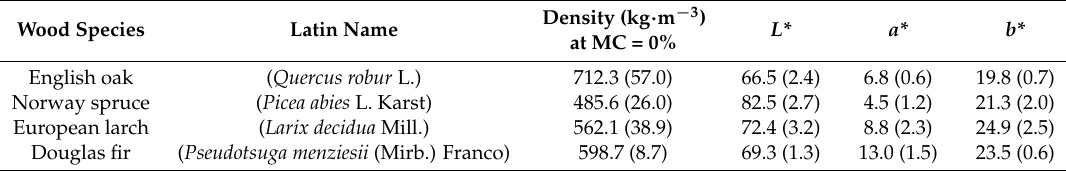
Density (kg · m − 3 ) at MC = 0%